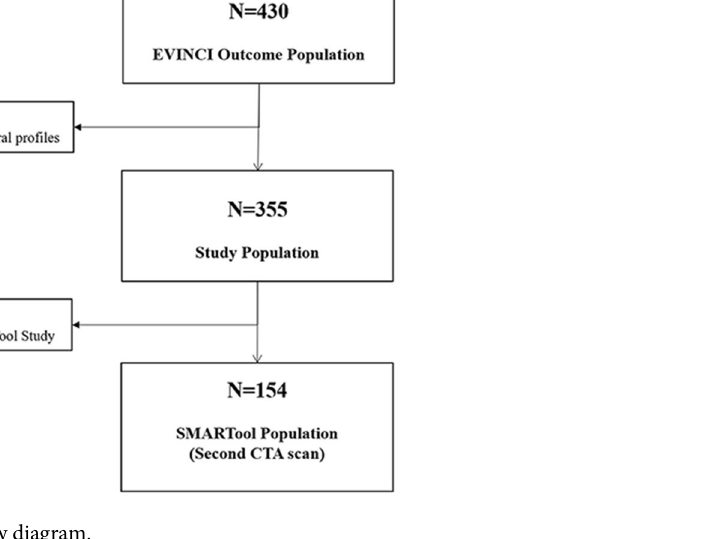
Figure 4. Study flow